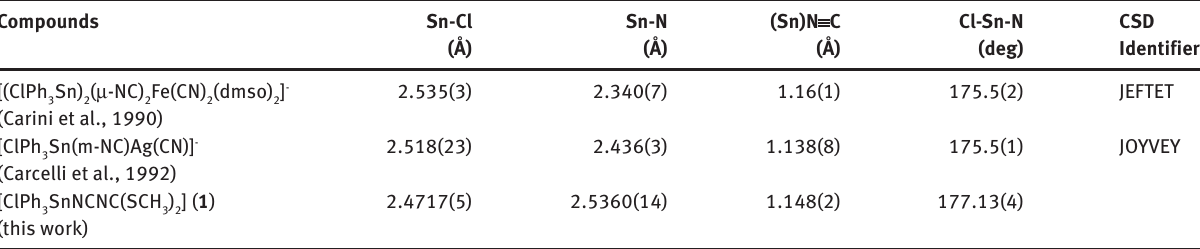
Table 2: Comparison of Sn-Cl, Sn-N, and (Sn)N ≡ C bond lengths (Å), and Cl-Sn-N angles ( ° ) in cyano derivatives of chlorotriphenyltin(IV) complexes.